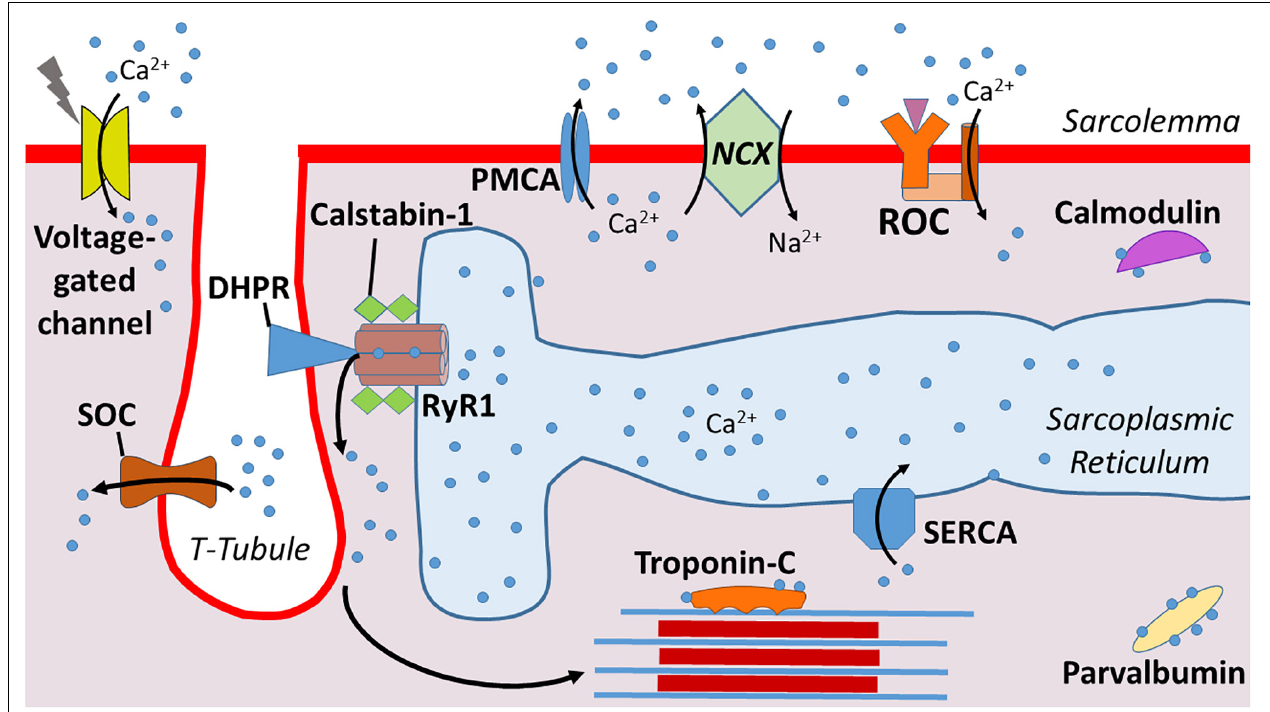
FIGURE 1 | Illustration of calcium (Ca 2 + ) regulation at the sarcolemma. Dihydropyridine receptors (DHPR) mediate Ca 2 + release from the sarcoplasmic reticulum into the cytosol. Calstabin-1 is bound to RyR1 and stabilizes this complex to aid in maintaining a closed channel. Ca 2 + is pumped back into the sarcoplasmic reticulum via sarcoplasmic reticulum Ca 2 + -ATPase (SERCA). Ca 2 + enters from the extracellular space via voltage-gated channels, store-operated channels (SOC), and receptor operated channels (ROC). Ca 2 + is excreted from the cytosol via plasma membrane Ca 2 + ATPases (PMCA) and Na + /Ca 2 + exchanger (NCX). Levels of cytosolic free Ca 2 + are also regulated by Ca 2 + binding proteins such as Troponin-C, parvalbumin, and